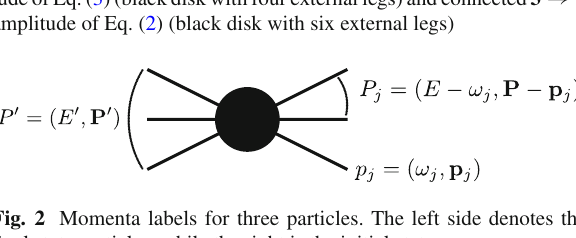
tering amplitude, as required by the LSZ construction